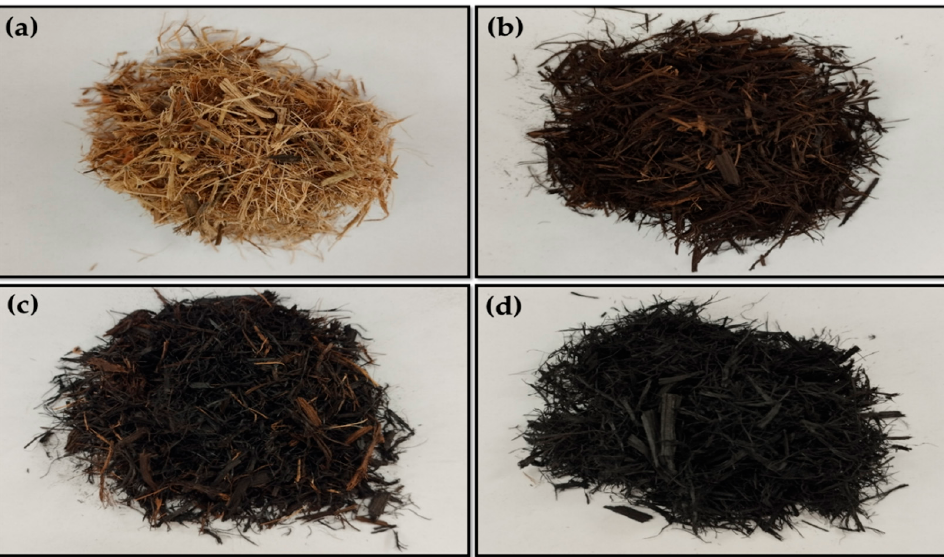
Figure 2. Photographs of sesame stalk feedstock and its different biochar types produced at 300 °C for 3 hrs: ( a ) sesame stalk feedstock (SF); ( b ) SB-1 biochar formed around the inner sidewalls of the internal chamber of the parabolic dish collector; ( c ) SB-2 biochar formed on the upper part of the internal chamber; and ( d ) SB-3 biochar of conventional method (muffle production).